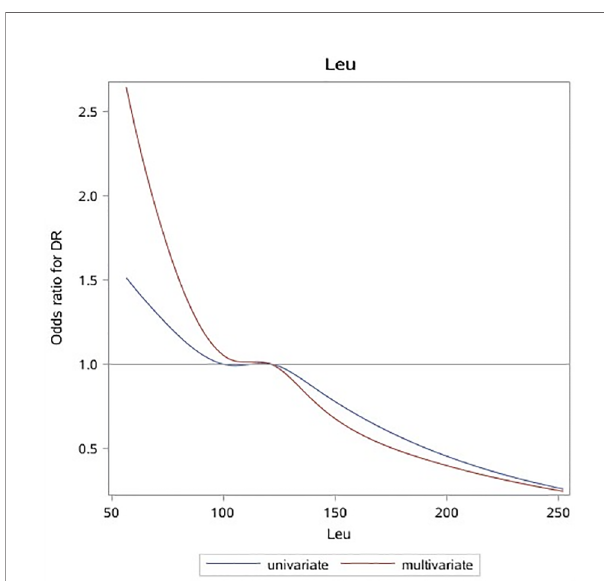
FIGURE 1 | OR curves of leu and DR in patients with T2D. The blue solid line represents the curve with only leu in the model, and the red dotted line represents the curve after adjusting for all baseline data, laboratory test indicators, and complications. It can be seen that leu is a protective factor of DR. OR, odds ratio; leu, leucine; DR, diabetic retinopathy; T2D, type 2 diabetes.